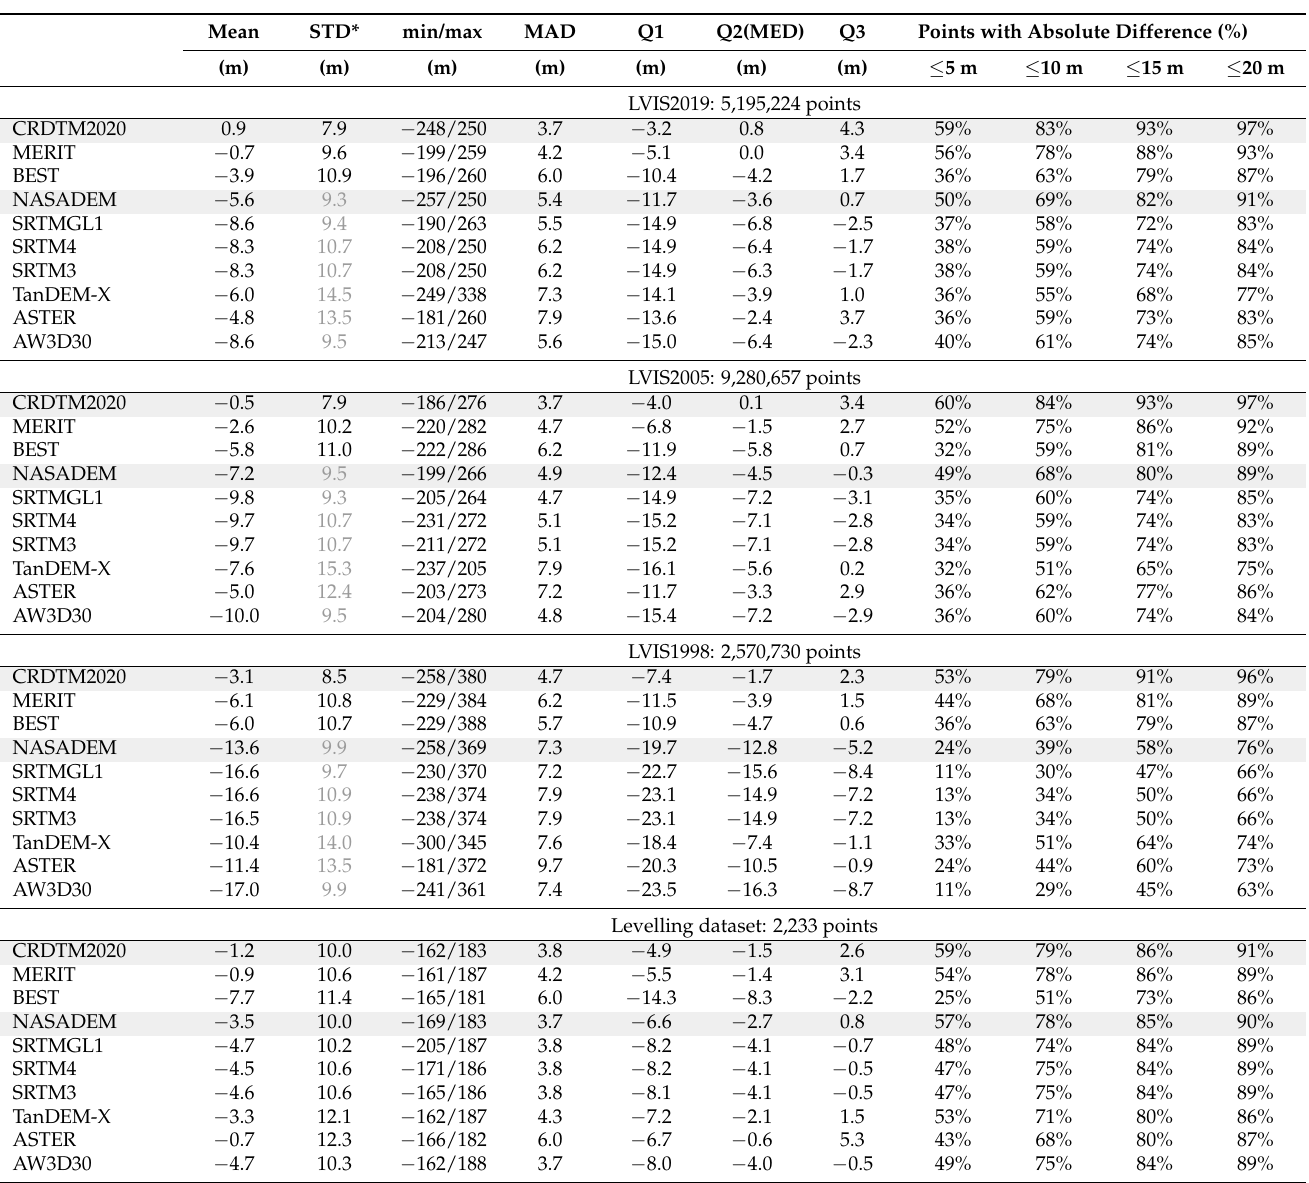
Table 4. Statistical analysis of the differences between LVIS lowest heights (ZG) and the heights of the nine DEMs interpolated on the same locations. The statistics is provided in terms of the mean difference, Standard Deviation (STD*) for differences without outliers larger than ± 50m, minimum and maximum differences (min/max), Median Absolute Difference (MAD), 25th empirical quartile Q1, the Median (MED) or the 50th empirical quartile Q2, the 75th empirical quartile Q3, and percentages of points having absolute differences below certain thresholds. STD* marked in grey indicates that differences for those DEMs are not normally distributed, and these values are not appropriate metrics for their evaluation. They are provided as they may be of interest, e.g., for comparison to other